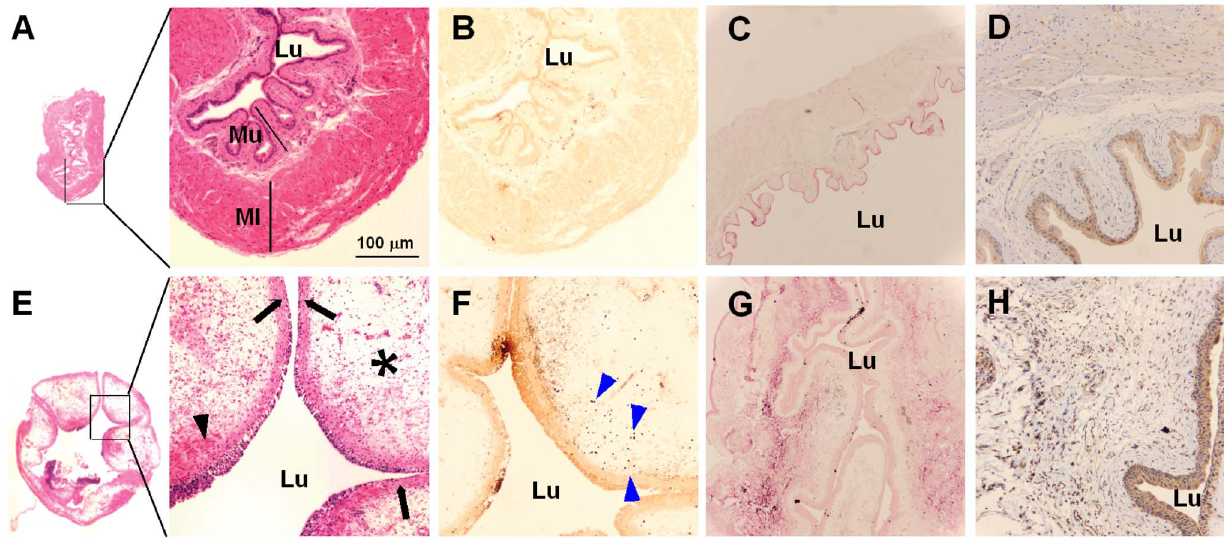
Figure 1. LL-37 induces inflammatory changes in the urinary bladder (A, B, C, and D: normal bladder; E, F, G, and H: 24 hr after 250 m M LL-37 treatment). Microscopic observations show that LL-37 causes edema (*), massive infiltration of leukocytes including PMNs and occasional hemorrhage (black arrow head) along with urothelial erosion (arrow). A and E are photostiched images of the entire bladder surface stained with H&E (lower panels are the enlarged views of the square regions). B and F are immunostained images for Ly6G, the surface antigen from PMNs (blue arrowheads). C and G are immunostained images for IL-6 showing strong immunoreactivities of IL-6 at the submucosal area in the LL-37 treated bladder. D and H are immunostained images for PTX-3 showing marked increase of PTX-3 positive cells in the LL-37 treated bladder. Lu: